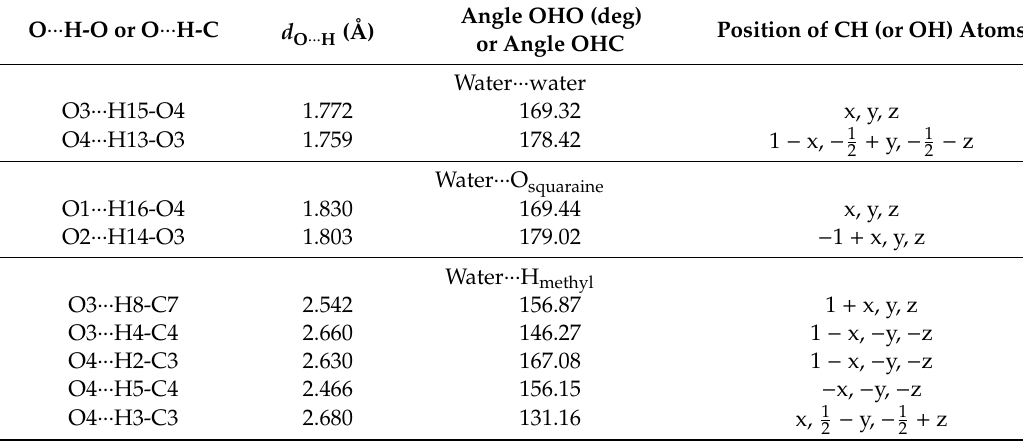
Table 5. Short a water contacts b in